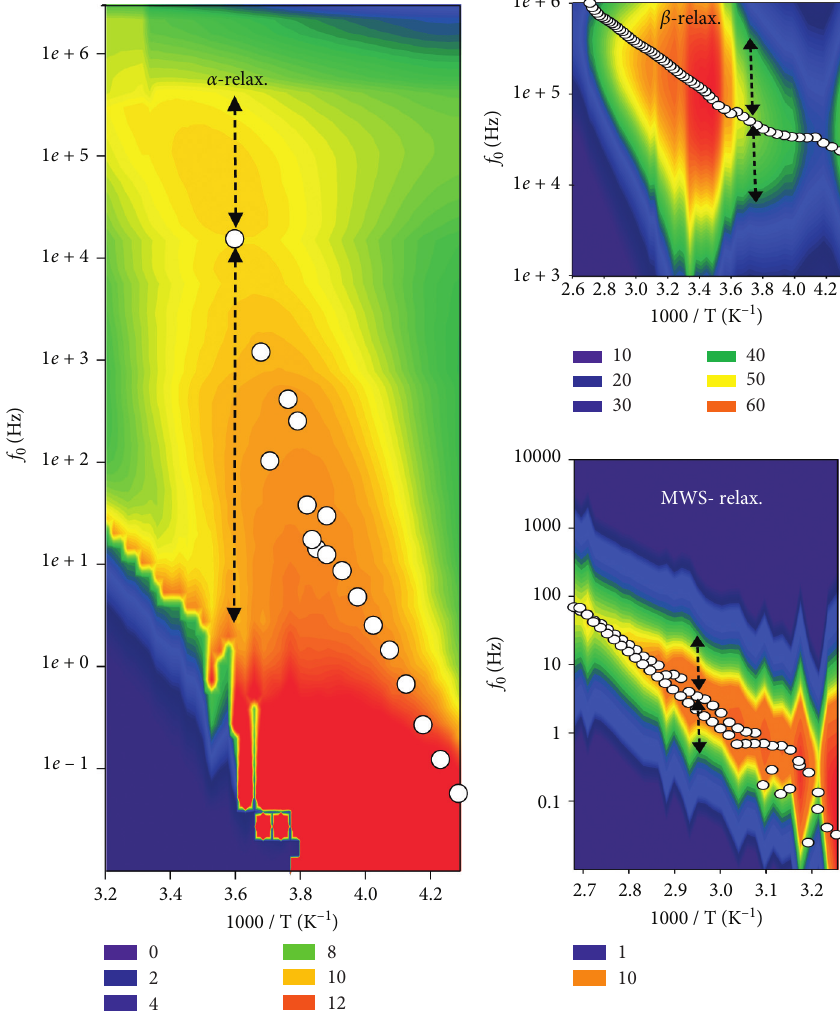
Figure 16: Relaxation rate and contour plot of the dielectric relaxation phenomena for EPDM. The overlapped circle symbols of MWS and α -relaxation just denote the repeated